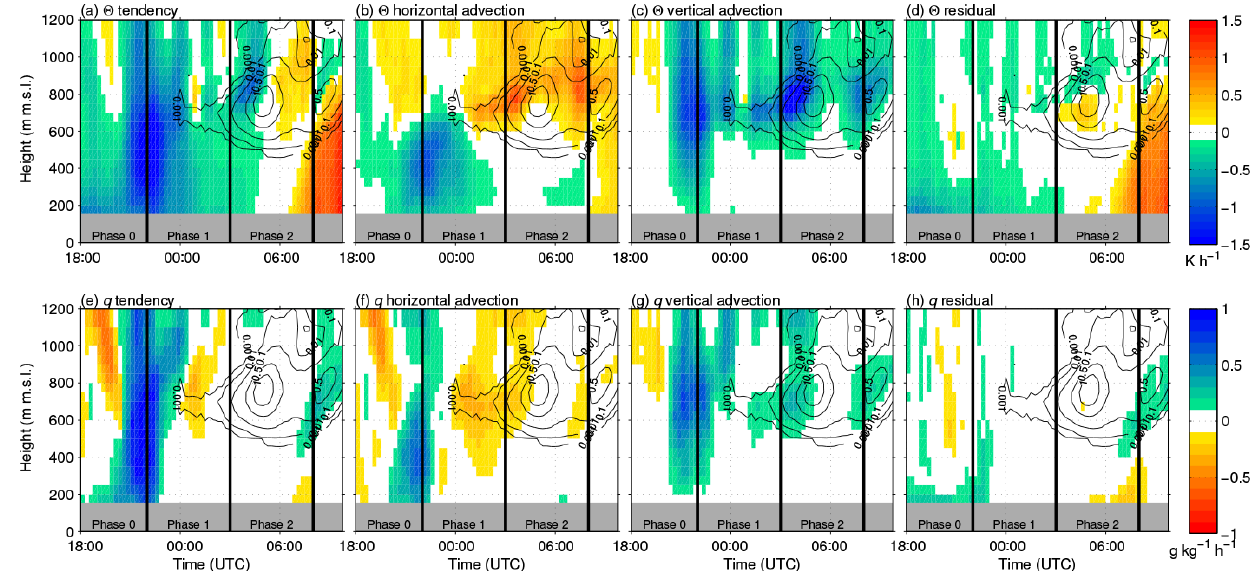
Figure 3. Temporal evolution of tendencies and of contributions to tendencies by horizontal advection and vertical advection for potential temperature (a–c) and moisture (specific humidity; e–g ) averaged for SAVE. The residuals are determined by subtracting the contributions by advection from the tendencies (d, h) . Liquid water content in gkg − 1 is indicated by the black contours. Grey shaded areas mark the mean terrain height.